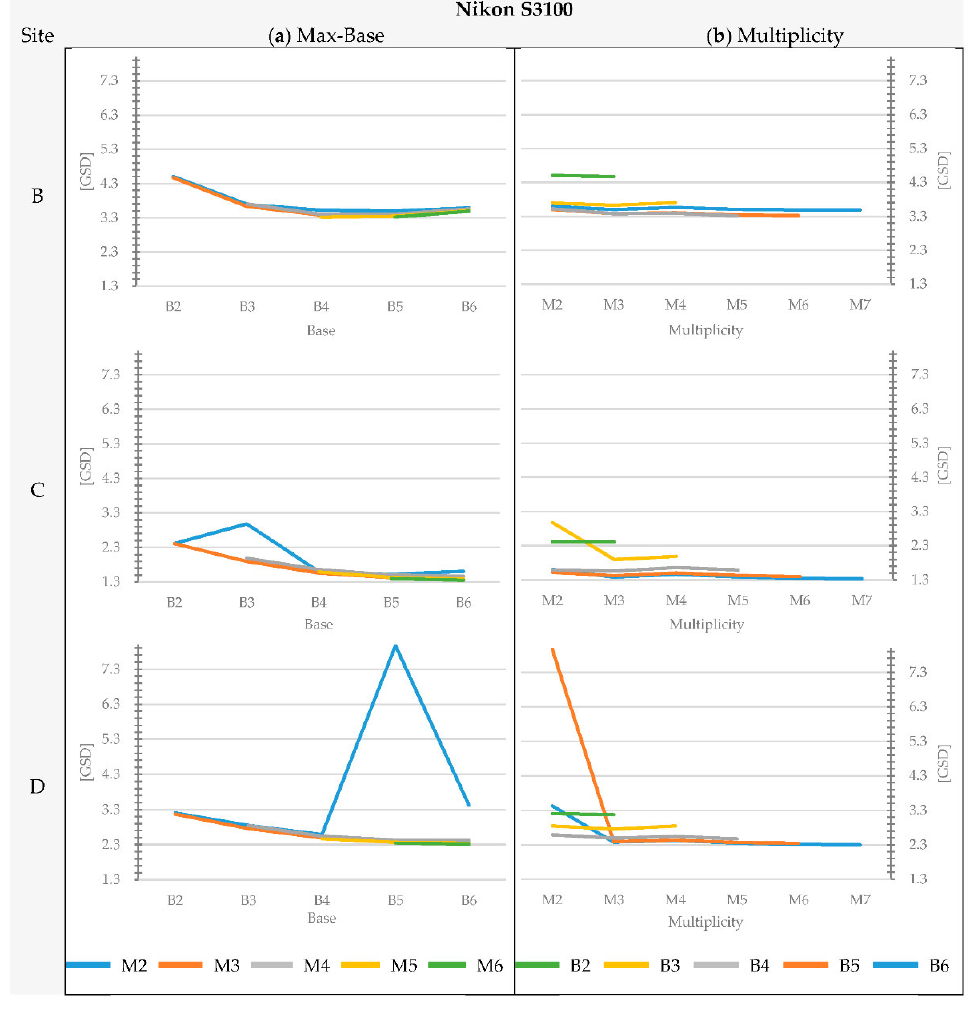
Figure 16. Graphs showing the standard deviation of the elevation disparity between DEMs and the reference model for Sites B, C and D, processed using MicMac, as a function of ( a ) the max ‐ base variability and ( b ) multiplicity. (Value of standard deviation for combinations B1 ‐ M2: B = 7.60, C = 4.22 and D = 5.02 times the GSD).